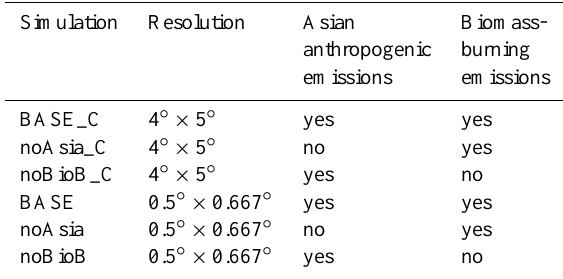
Table 1. Summary of the GEOS-Chem-TOMAS simulations used in this study. Note that C indicates coarse simulations (4 ◦ × 5 ◦